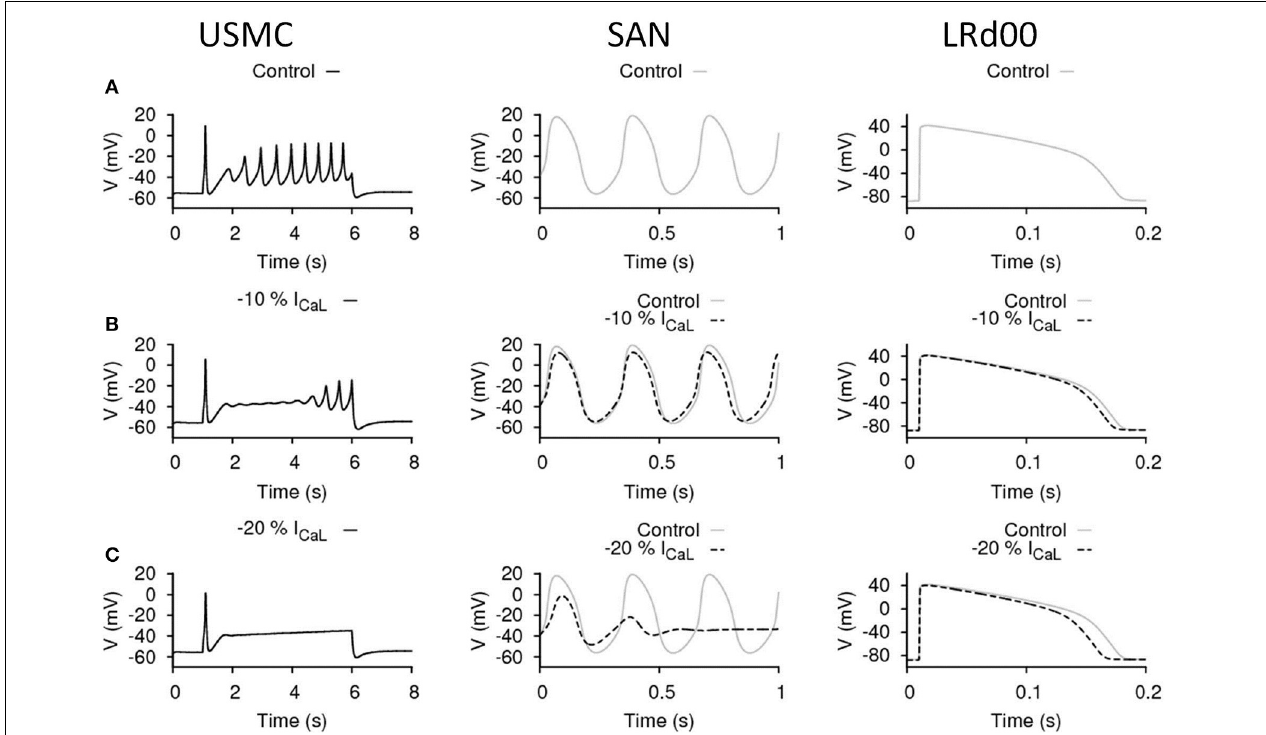
LRd00 ventricular cell model (right). (A) Control configuration at full I CaL and the effects of reducing I CaL by (B) 10% and (C) 20%. The negative sign indicated